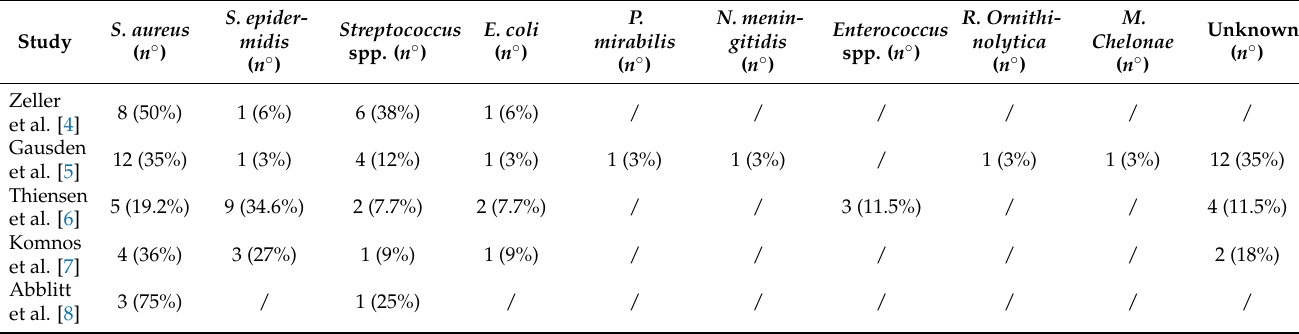
Table 4. Bacteria associated with synchronous PJIs.